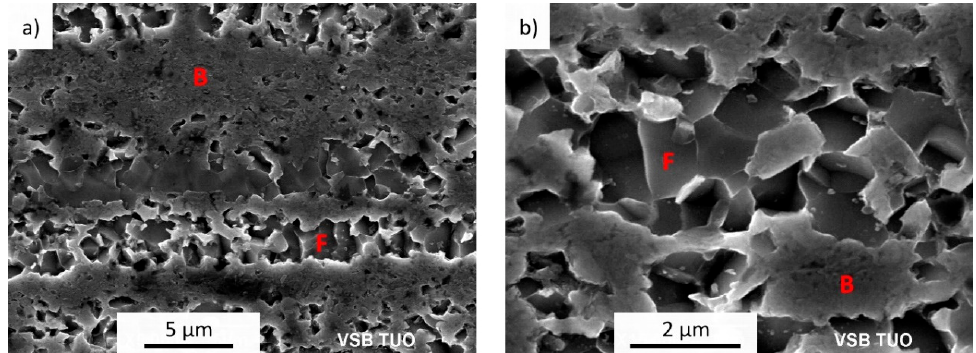
Figure 22. SEM analysis of the sample deformed at a temperature of 650 °C and a strain rate of 20 s − 1 . ( a ) flattened bainitic agregates ( B ) and recrystallized ferritic grains ( F ); ( b ) detail of the equiaxed recrystallized grains of ferrite.